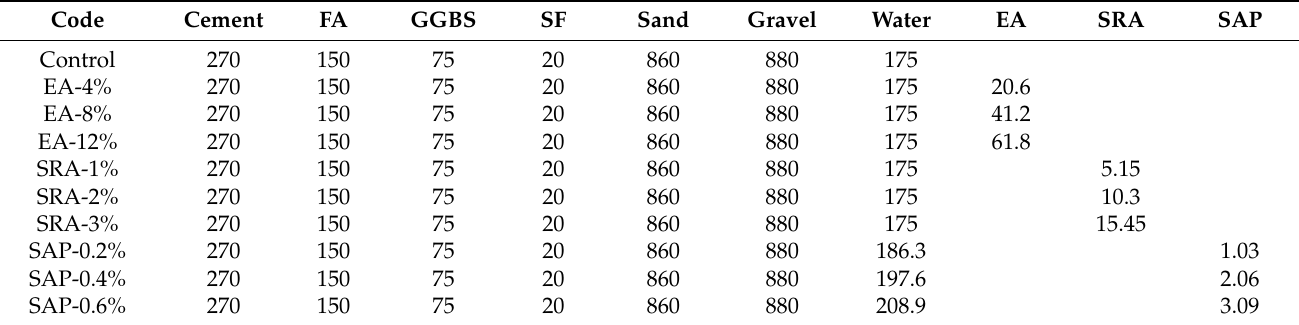
Table 2. Proportions of concrete mix (kg/m 3